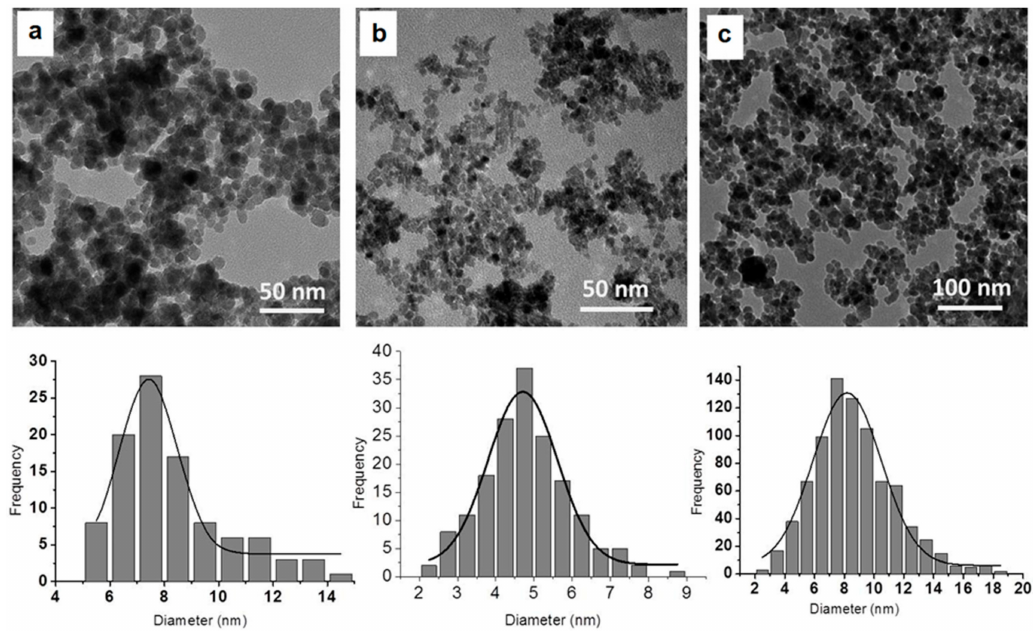
Figure 5. Transmission electron microscopy (TEM) micrographs of MPEI ( a ) CePEI ( b ) and MCePEI-GA ( c )